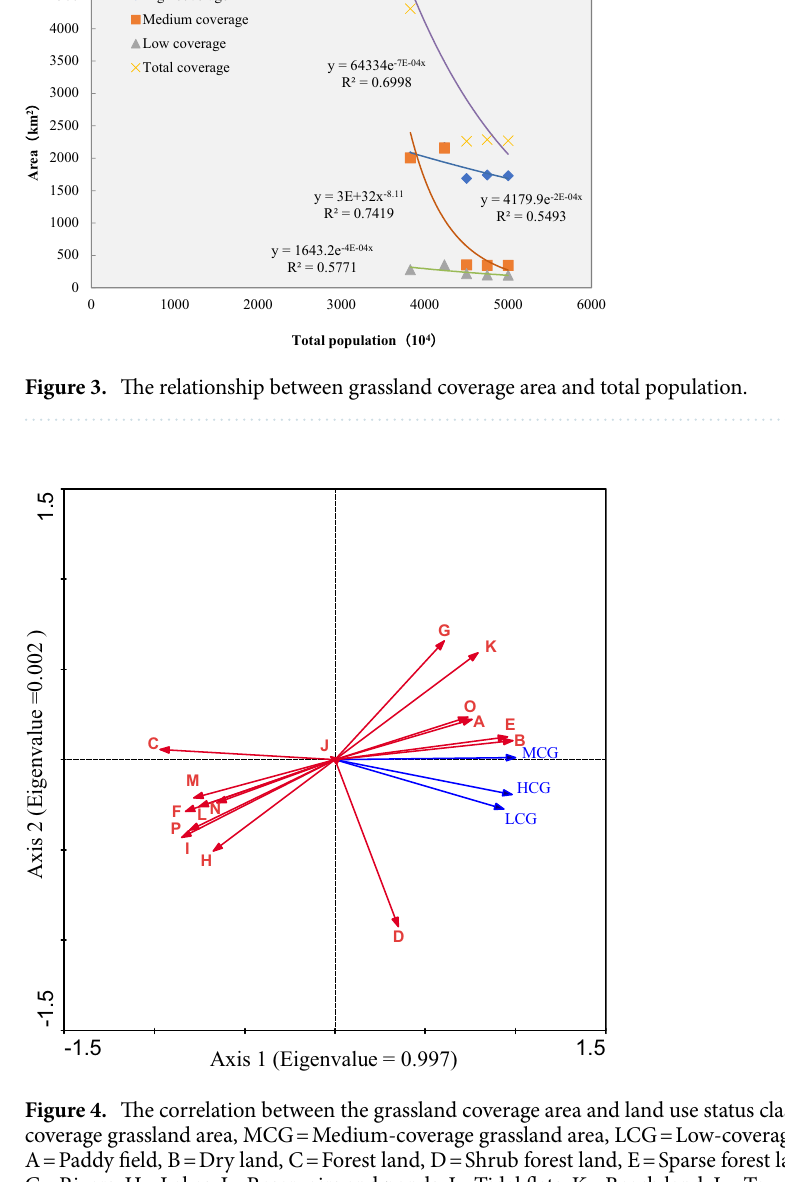
(RDA) results indicated that the correlation between the grassland coverage area and land use status classifi- cation had a significant division along the first RDA axis (Eigenvalue = 0.997). High-coverage grassland area, medium-coverage grassland area and low-coverage grassland area had strongly positive correlation with paddy fields (A), dry land (B), shrub forest land (D), sparse forest land (E), beach land (K), bare land (O), and rivers (G), had strongly negative correlation with forest land (C), other forest land (F), lakes (H), reservoirs and ponds (I), towns (L), rural residential land (M), industrial and construction land (N), bare rock and gravel land (P), had week correlated with tidal flats(J) (Fig. 4).